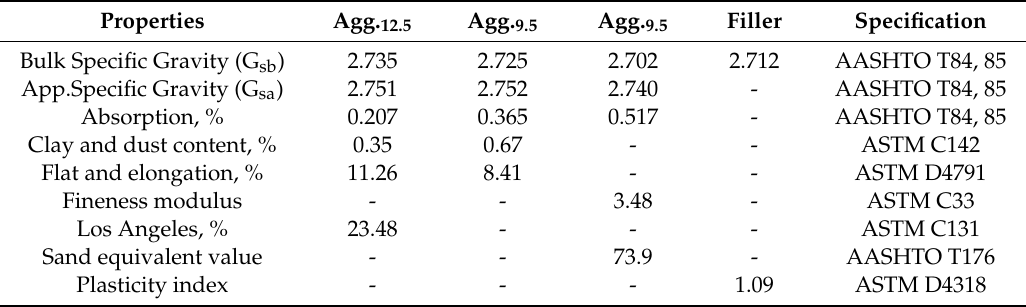
Table 1. Properties of aggregates and mineral filler.